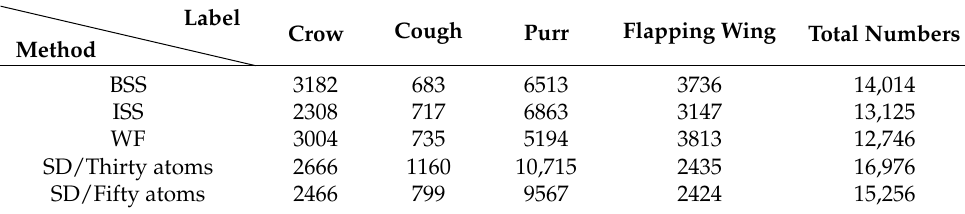
Table 2. Specific description of five data sets corresponding to five signal filtering